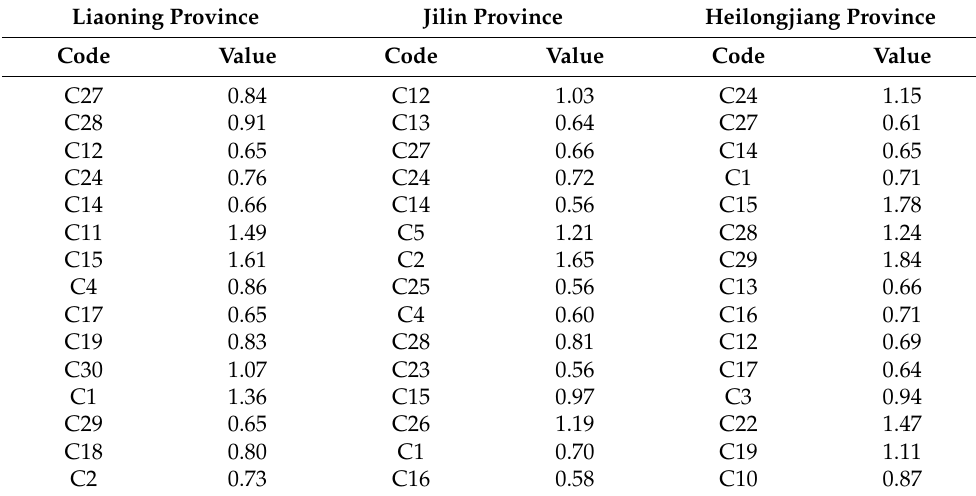
Table 6. Top 15 industry sectors in KATZ index